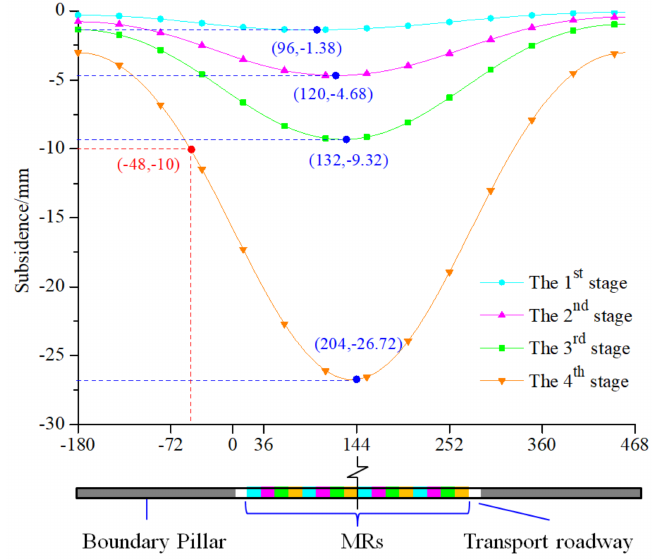
Figure 13. The subsidence amount of the surface center line along the strike direction after mining.